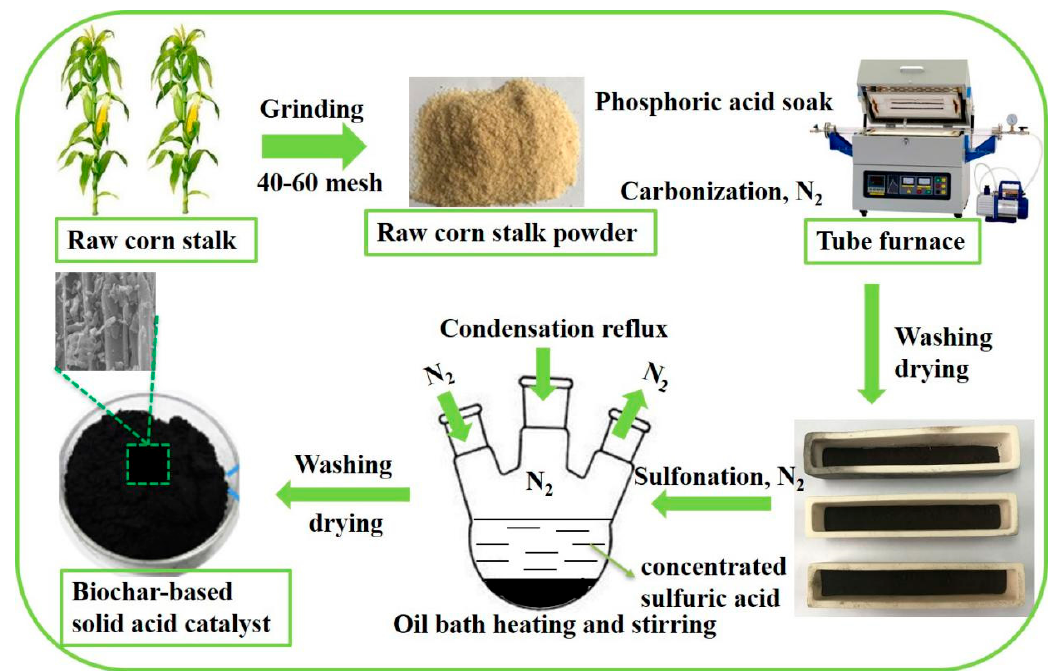
Figure 1. Schematic synthesis of biochar-based solid acid catalyst.